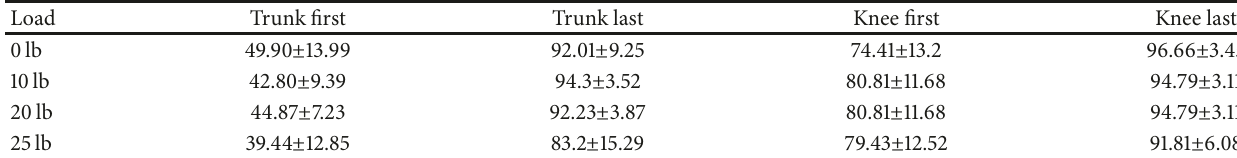
Table 1: Trunk and knee angles when “D” force is